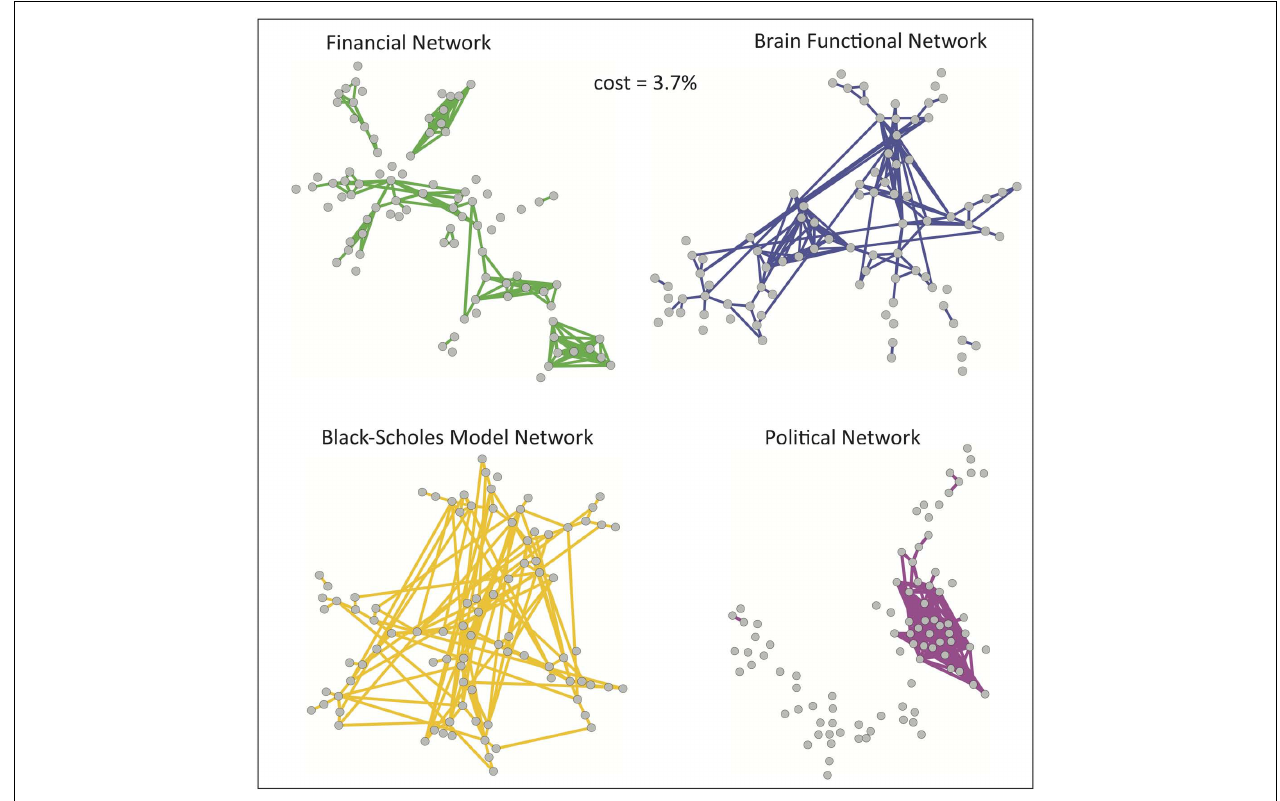
network (green) and the brain functional network (blue) is not shared by the political network based on roll-call data (magenta) and the model network based on Black–Scholes